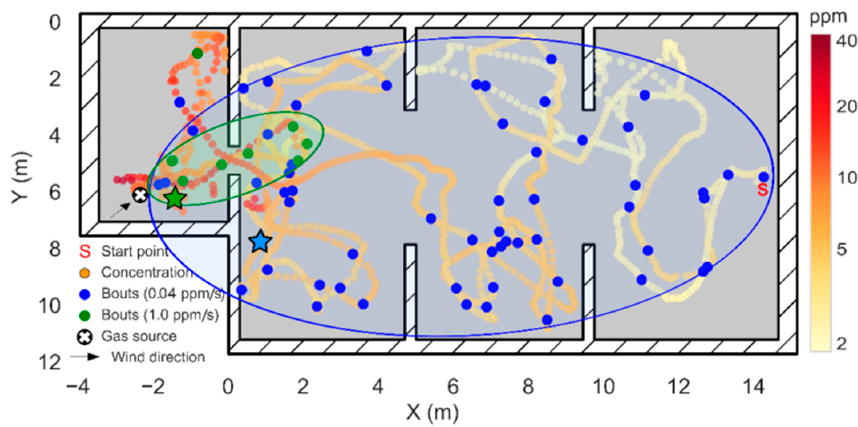
Figure 16. Effect of the bout amplitude threshold in the results of Experiment 1. The blue circles represent bouts with amplitude higher than 0.04 ppm/s ( µ + 3 σ threshold) and the green circles represent bouts with amplitude higher than 1.0 ppm/s. In each case, a hand-drawn ellipse outlines the approximate plume shape based on the location of the bouts. The green and blue stars indicate the source location estimate in each case, according to the maximum bout frequency.